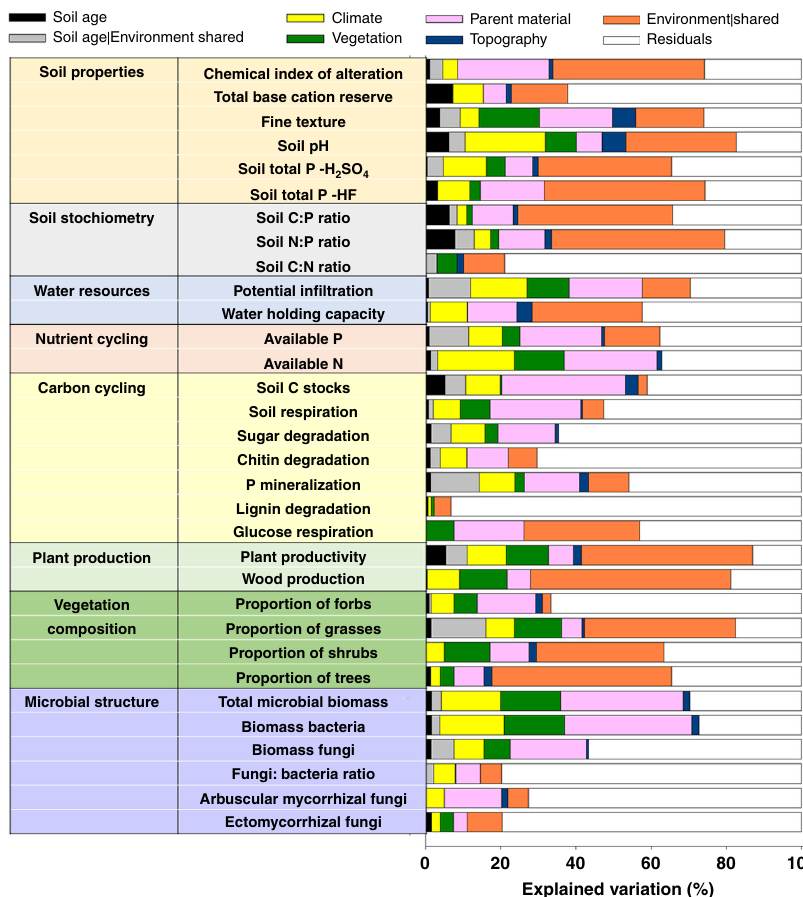
Fig. 2 Contribution of the ecosystem development state factors to the structure and function of terrestrial ecosystems across global biomes. Variation Partitioning Modeling was used to evaluate the unique and shared portions of variation in ecosystem properties explained by soil age, climate, vegetation type, parent material, and topography. Environmental | shared refers to the percent of shared variation in ecosystem properties explained by parent material, climate, vegetation type, and topography. Soil age | shared refers to the percent of the shared variation in ecosystem properties explained by soil age, parent material, climate, vegetation type, and topography. P -values associated with the unique portions explained by different groups of predictors are available in Supplementary Table 5. Detailed information on the n , units, rationale, descriptions, and acronyms for these functional and structural properties can be found in Supplementary Table 3. The CIA (chemical index of alteration) and the TBR (total base cation reserves) indices provide information on the relative extent of